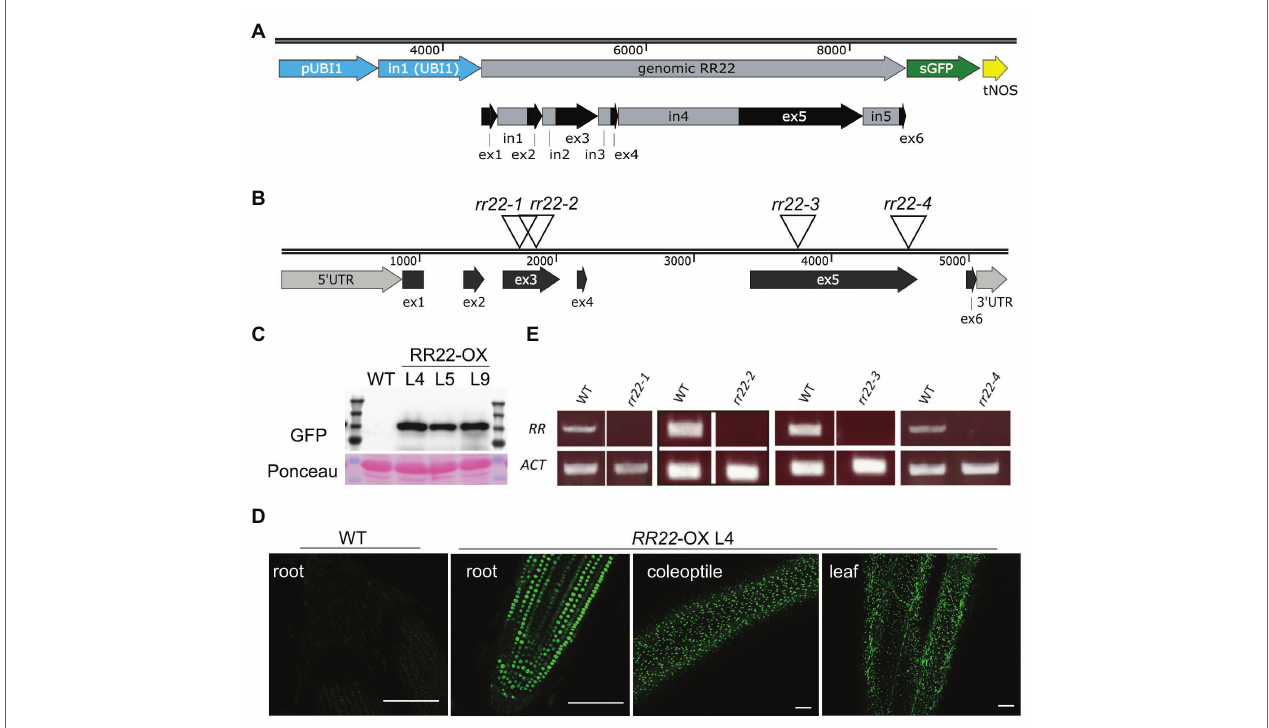
FIGURE 1 | RR22 gain-of-function and loss-of-function lines. (A) Structural design of the RR22-OX cassette. A genomic version of RR22 was expressed from the Zea mays UBI1 promoter incorporating the first intron of the UBI1 gene. A sGFP fluorescent tag was encoded at the 3 ' -end of RR22 . The intron/exon structure of the RR22 gene is shown below the cassette diagram. (B) Insertional positions for the four Tos17 alleles of rr22 . (C) Relative protein expression levels of RR22-GFP in three independent RR22 -OX lines as assessed by immunoblot using an anti-GFP antibody. A non-transgenic wild-type (WT) extract serves as a negative control. Ponceau S staining was used as a protein loading control. (D) Distribution of RR22-GFP fluorescent signal in root, dark-grown coleoptile, and leaf of RR22 -OX L4. The WT root is a negative control. Scale bar = 100 μ m. (E) Transcript levels of rr22 and ACT1 in the Tos17 rr22 mutant lines and corresponding WT siblings assessed by semiquantitative